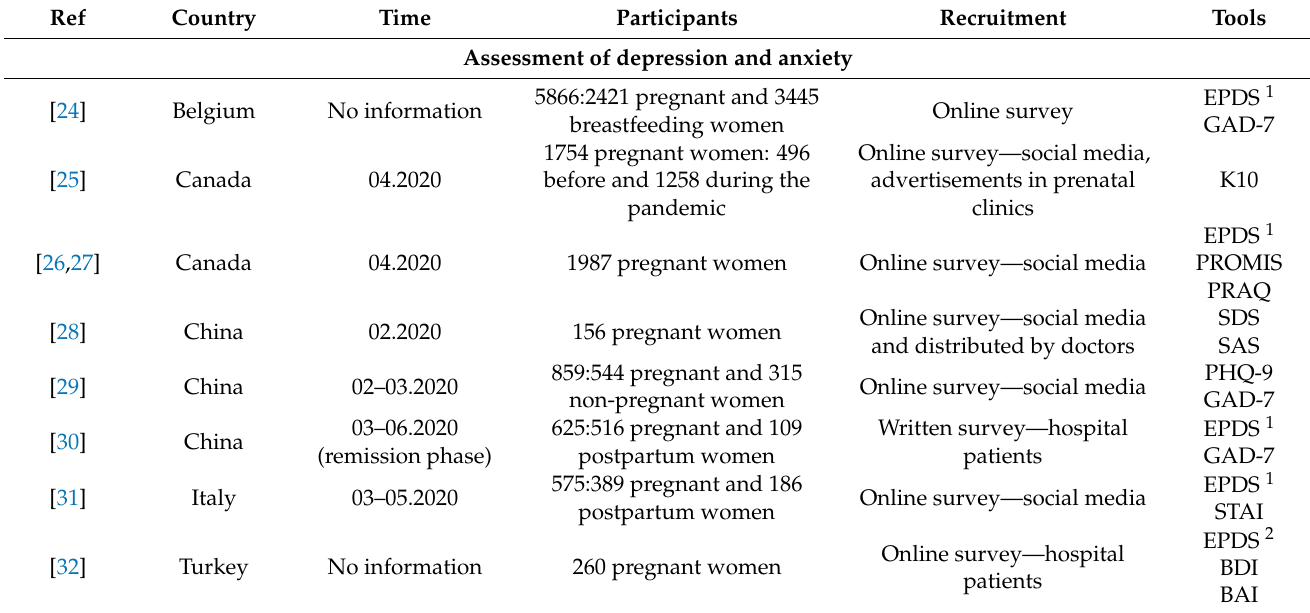
Table 1. Characteristics of the selected studies.